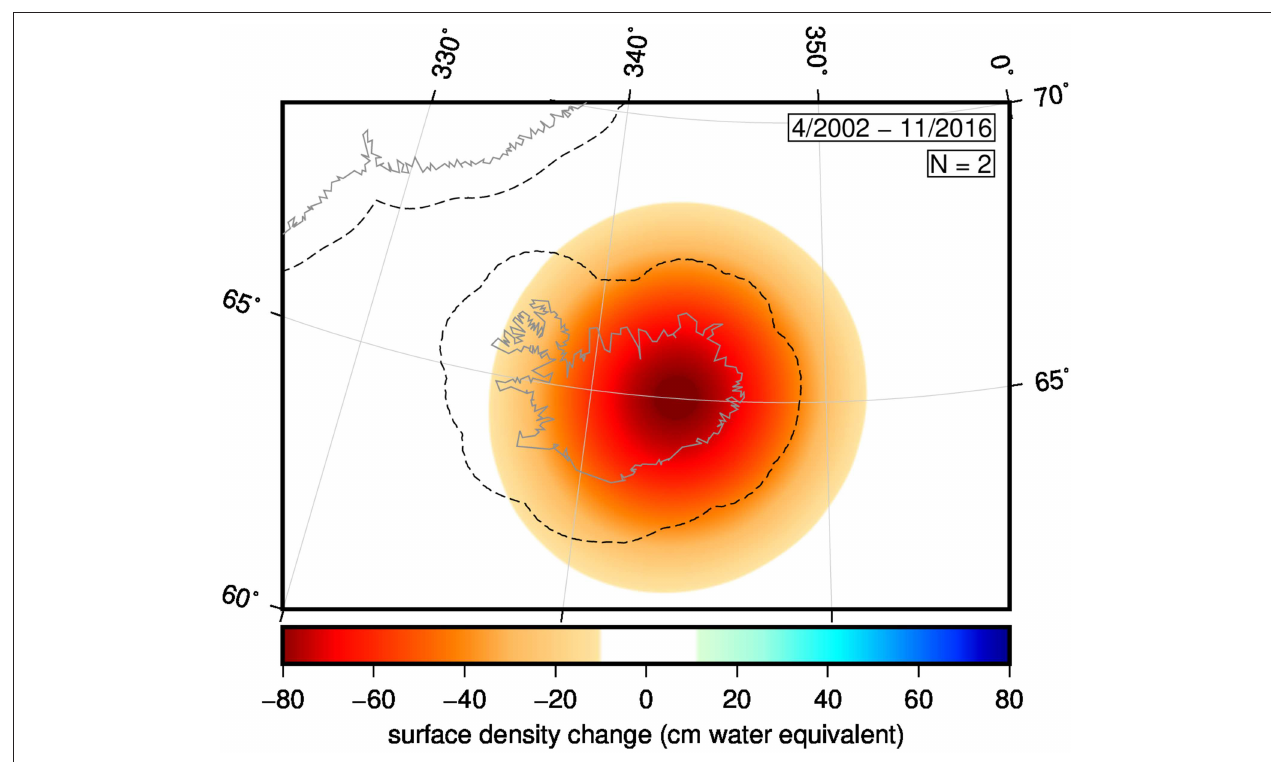
FIGURE 5 | Geographic pattern of mass change over Iceland, shown in centimeters water equivalent. The dashed border in the northwest is the 0.5 ◦ buffer around Greenland, and the similar dashed border around Iceland is its 1.0 ◦ buffer. The figure represents the total mass change over the date range specified in the top right. Below the date range is the Shannon number N = 2 for the buffered region and bandwidth of 60, indicating that the figure represents the sum of two optimal Slepian functions, as pictured in Supplementary Figure 1 .